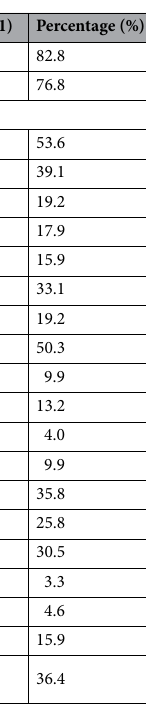
Table 3. Musculoskeletal health issues relating to activity in